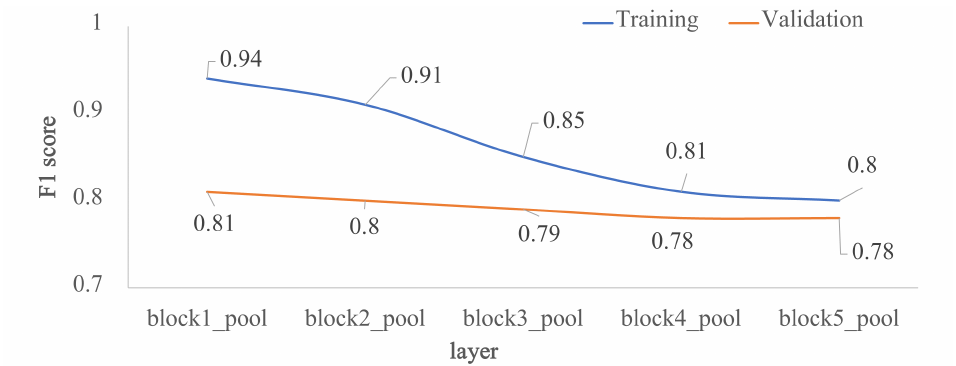
Figure 4. Impact of the depth for the custom architecture in terms of F1 score: training vs validation. The x -axis corresponds to the last layer before the FC1 layer, and the y -axis is the F1